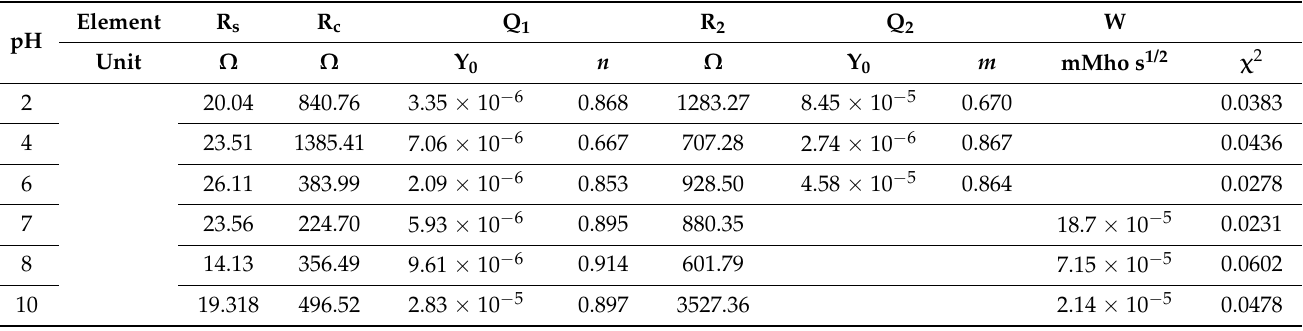
Figure 9. ( a ) Chronoamperogram of sequential addition of nitrite to the drinking water solution, ( b ) Typical calibration curve of nitrite detection in drinking water. ( c ) Chronoamperogram of the low concentration range for sequential addition of nitrite. ( d ) The corresponding calibration curve for low-concentration addition of nitrite ion. Table 2. The Fitting parameters of GC/PANI/NiOnF at different pH values.